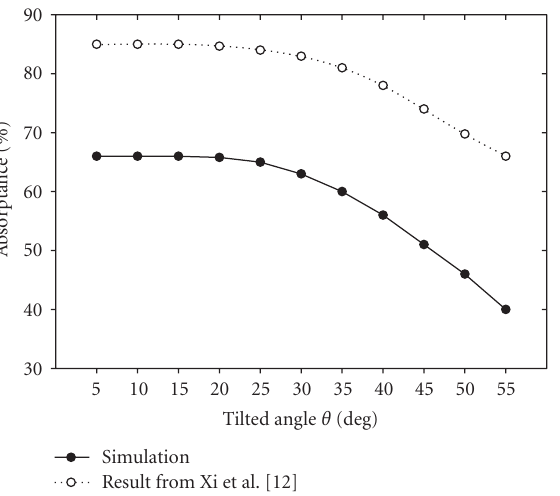
Figure 4: The relation of absorptance and the tilted angle, agreeing with the result of Xi et al.